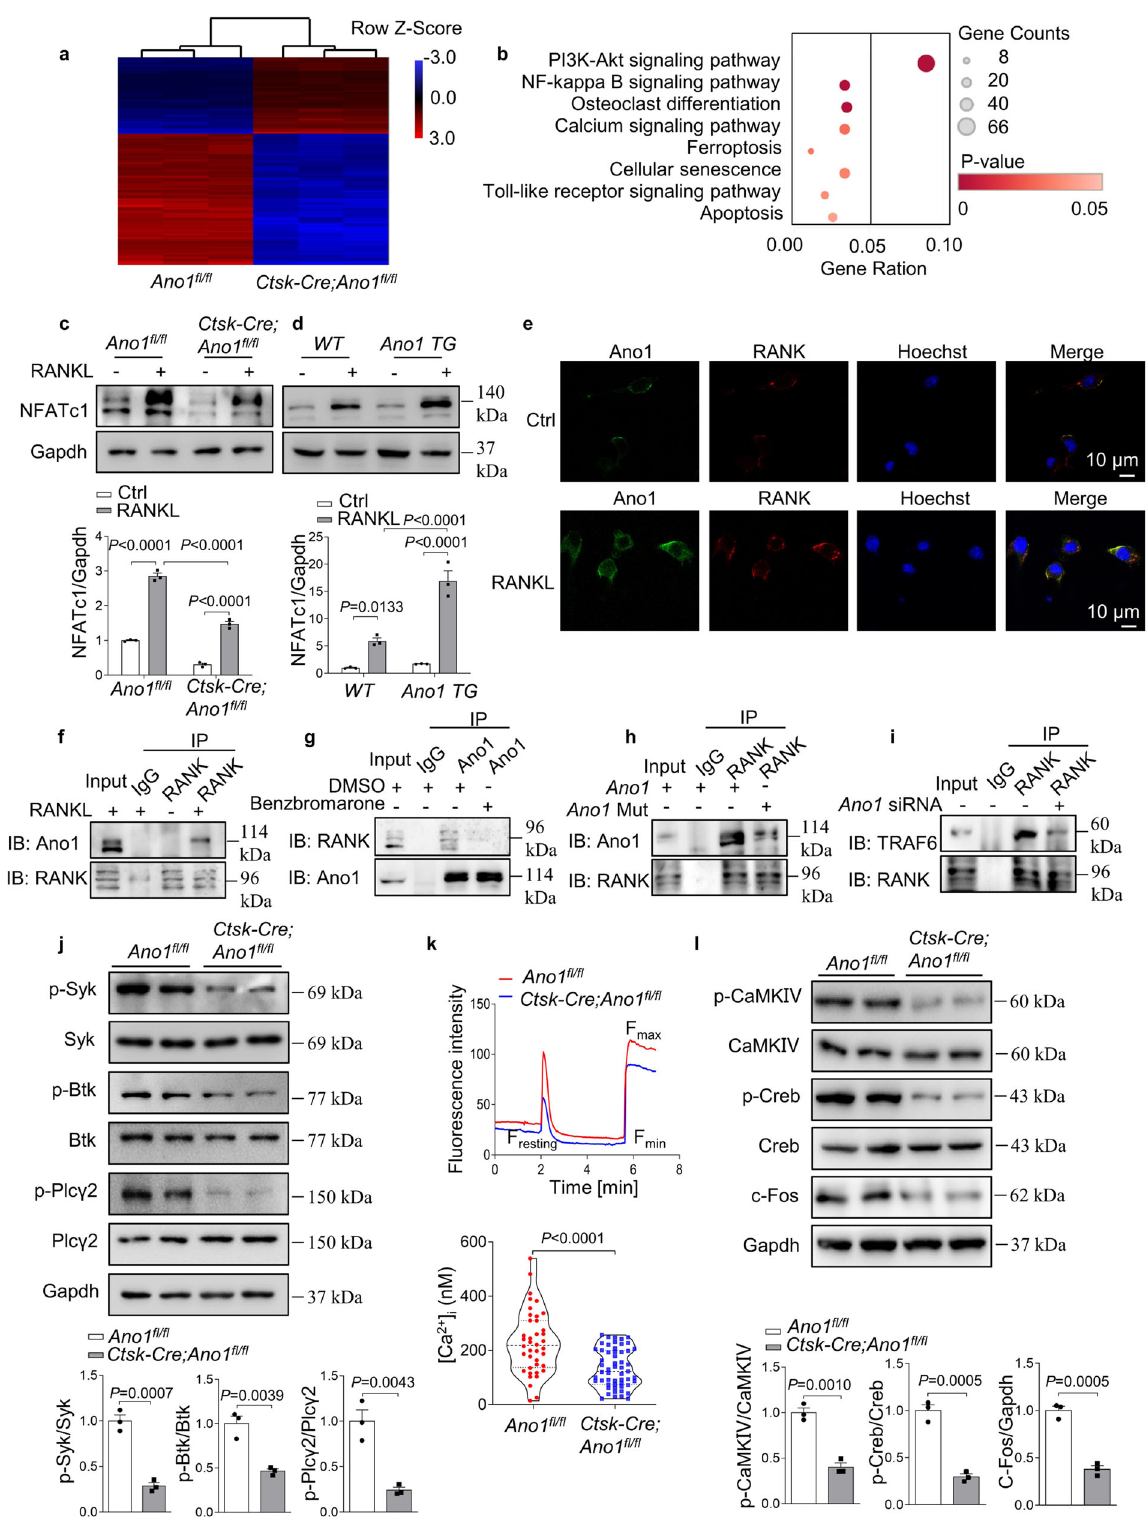
bone remodeling has been unknown. Here, we determined that Ano1 is present in osteoclasts and plays an essential role in osteoclastogenesis and bone resorption. Ano1 levels were obviously elevated during osteoclastogenesis and in the bone tissues of osteoporosis patients, and were positively correlated with osteoclast